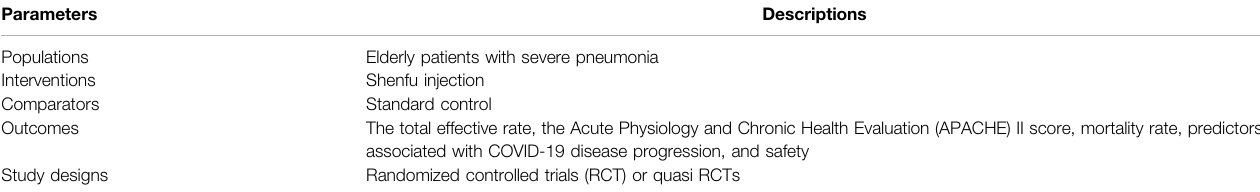
TABLE 1 | Participants, intervention, comparators, outcomes, and study design (PICOS).